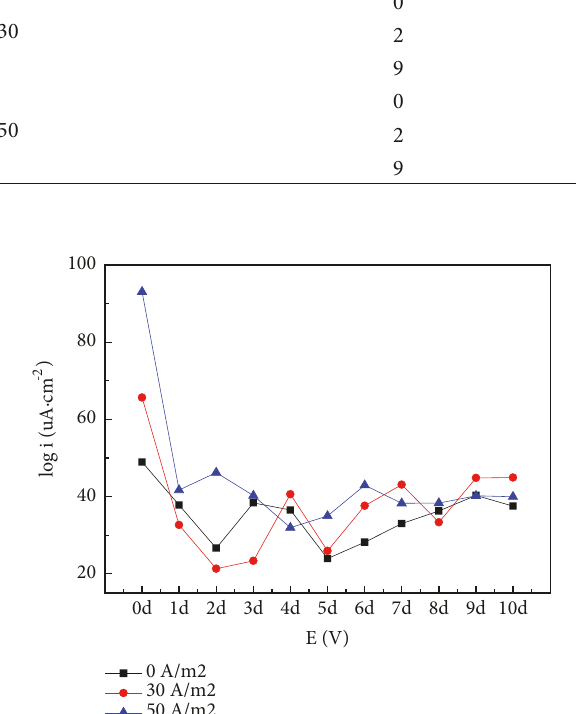
Figure 5: Relationship of corrosion current density with time under different AC current